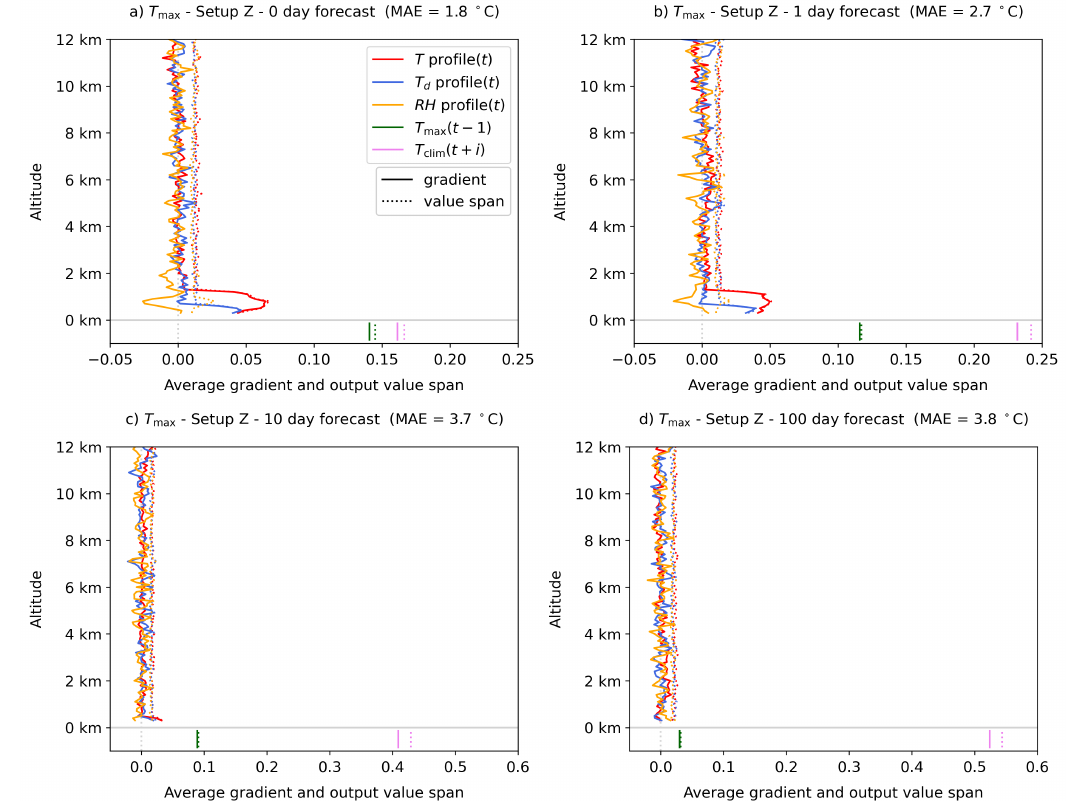
Figure 7. Same as Figure 6 but for forecasts of Setup Z instead of Setup X. The values for input parameters T max ( t − 1 ) and T clim ( t + i ) are indicated by short vertical lines in the lower part of the